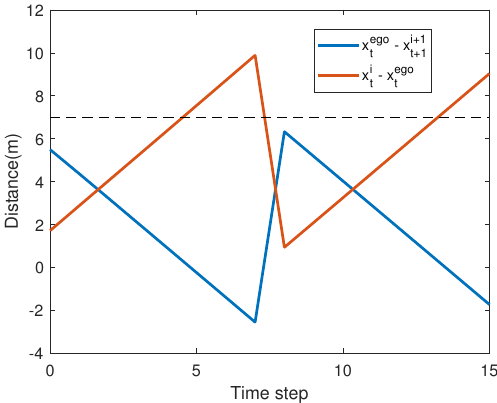
Figure 9. Calculated distance for rule-based